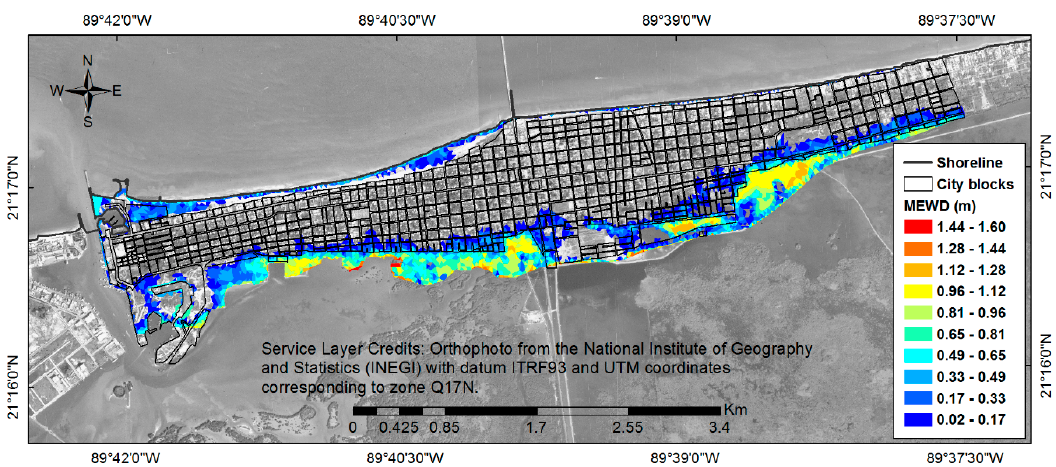
Figure 2. Flood map of the Norte event for Progreso, Yucatan.